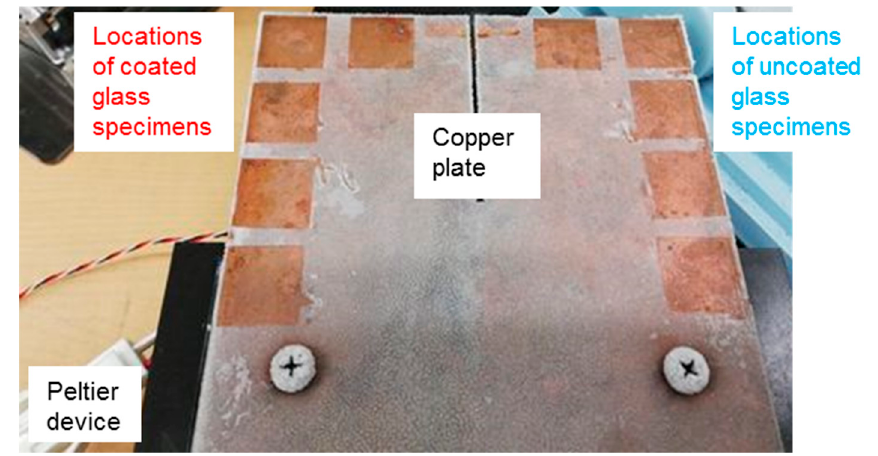
Figure 2. Arrangement of ten specimens on the copper plate. These specimens were already removed from the copper plate for the frost weight measurement. The thermocouple was occasionally not glued to the copper plate.